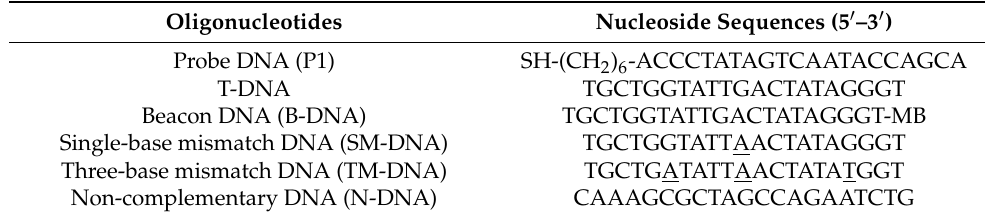
Table 1. Oligonucleotide sequences. Oligonucleotides